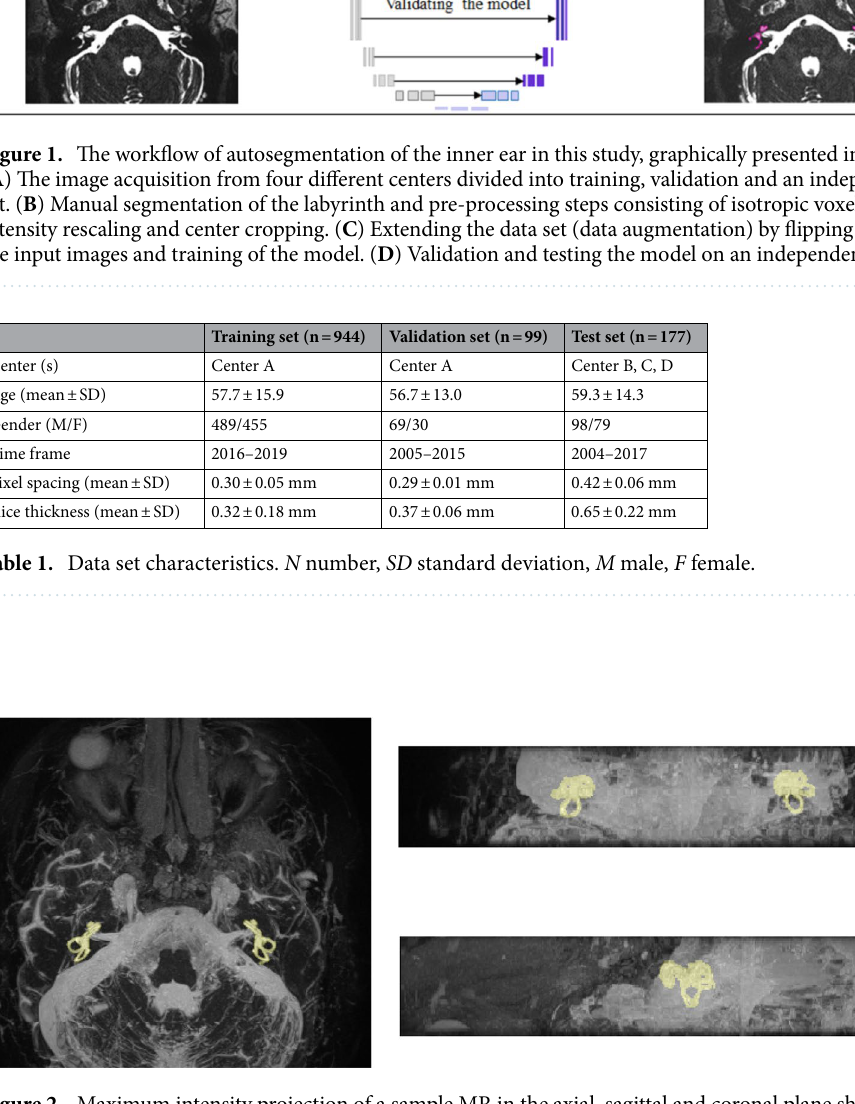
Figure 2. Maximum intensity projection of a sample MR in the axial, sagittal and coronal plane showing a manual segmentation of the labyrinth in yellow. Left: axial plane, right top: Coronal plane, right bottom: sagittal